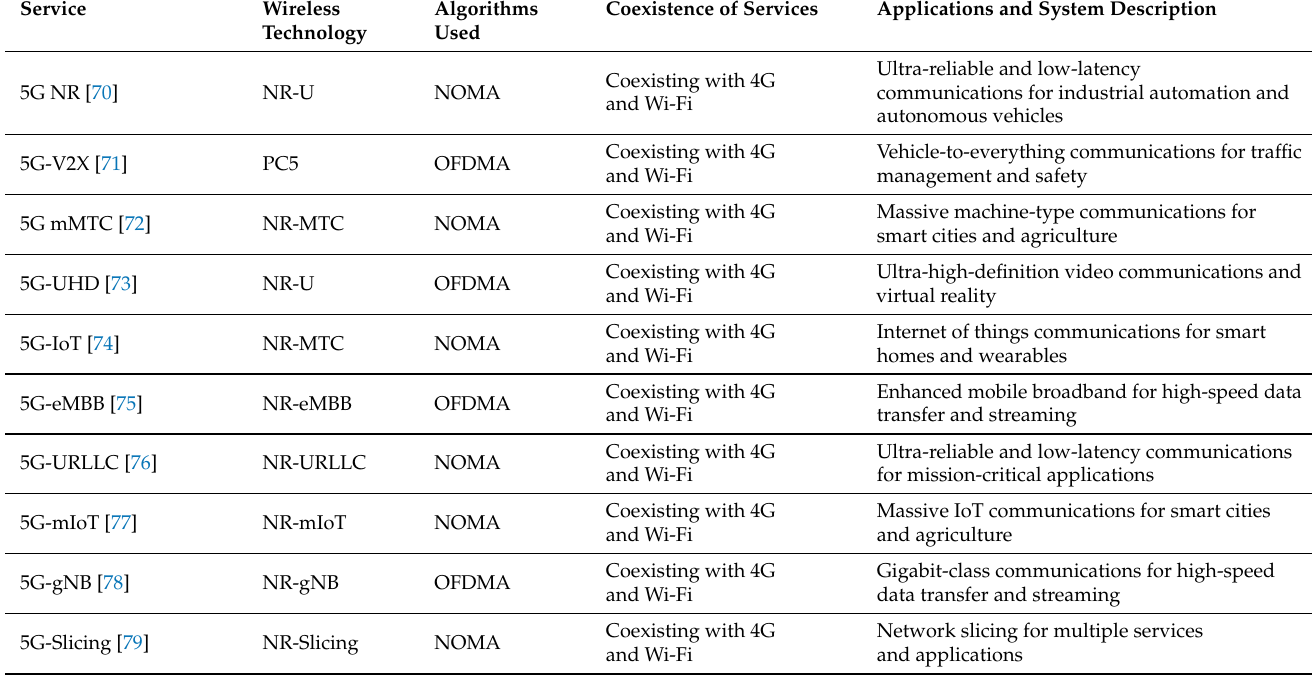
Table 3. Coexistence of 5G services and networks and Internet of things